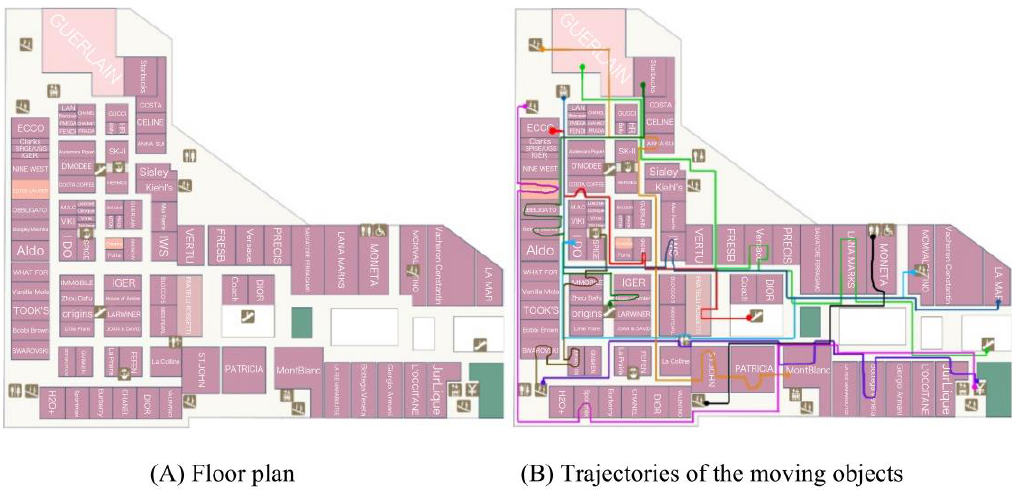
Figure 17. ( A,B ) Floor plan of the real environment and the trajectories of the moving objects.